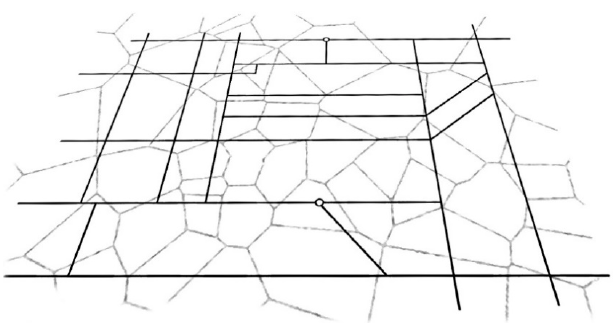
Figure 1. The links of the road network are divided by zones.